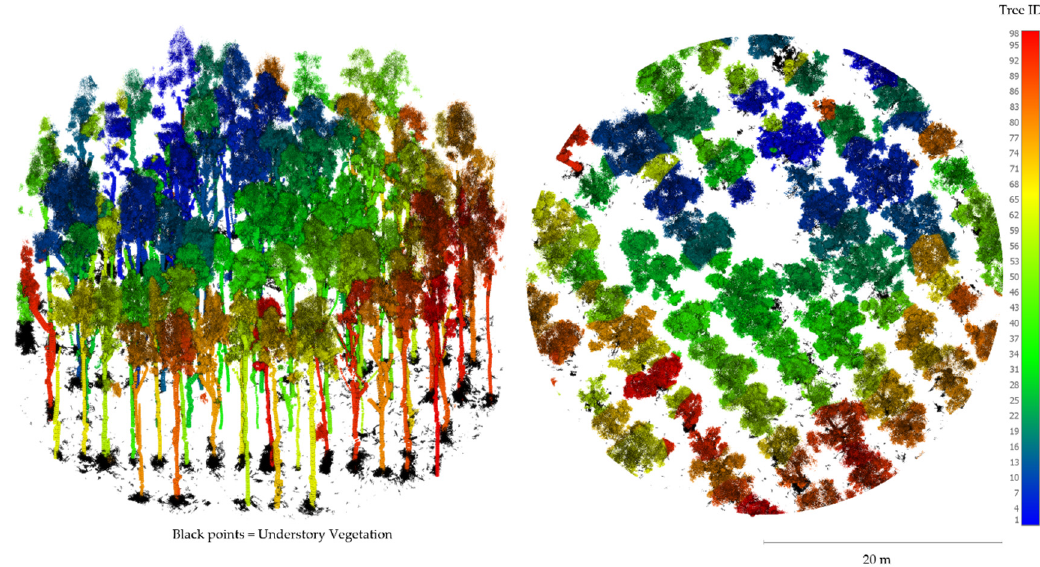
Figure 8. Initially, any vegetation points less than 3 m above the DTM are classified as understory (black points). The remaining vegetation points are assigned to be the same tree as the nearest cylinder measurement in X and Y coordinates, provided that they are within a horizontal radius of 1 m (this can be adjusted). If there are no cylinders within a 1 m radius, the points are deleted. The trees shown above are coloured by their assigned Tree ID. Please note that adjacent trees may appear to be labelled as the same colour (due to random colour assignment), however, they were all successfully separated as different trees in this example.